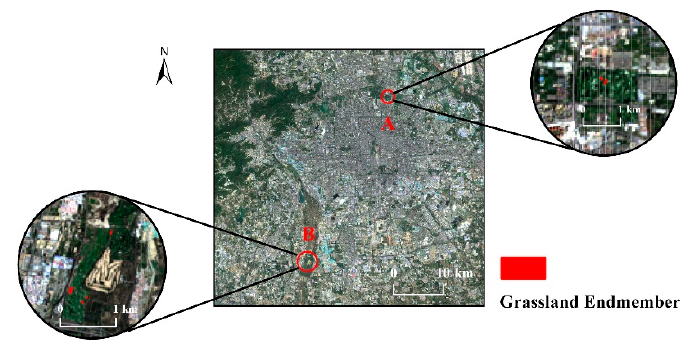
Figure 6. Schematic diagram of sampling locations in urban and suburban areas. Note: A is in the urban area and B is in the suburban area.